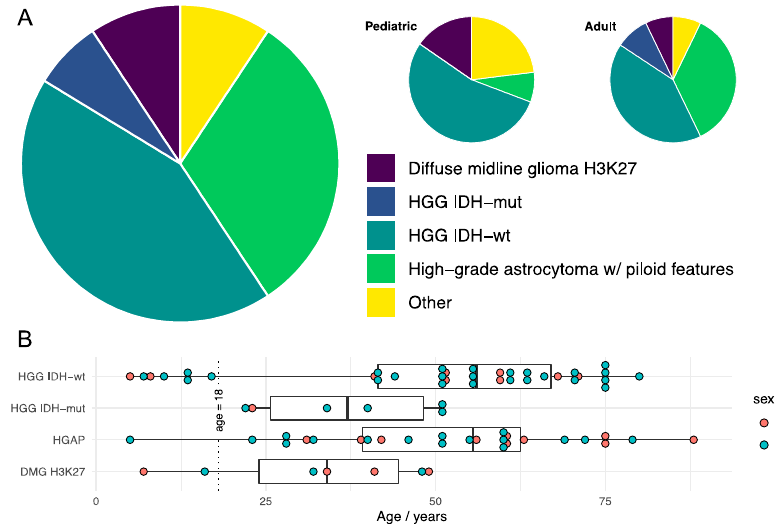
Figure 3. Molecular integrated diagnosis of histological cerebellar high-grade glioma. ( A ) Example proportions of subclass diagnosis of histological cerebellar high-grade glioma following integration of advanced molecular analyses. ( B ) Example age distribution of patients by integrated tumor diagnosis. Data from Reinhardt et al. [25] .